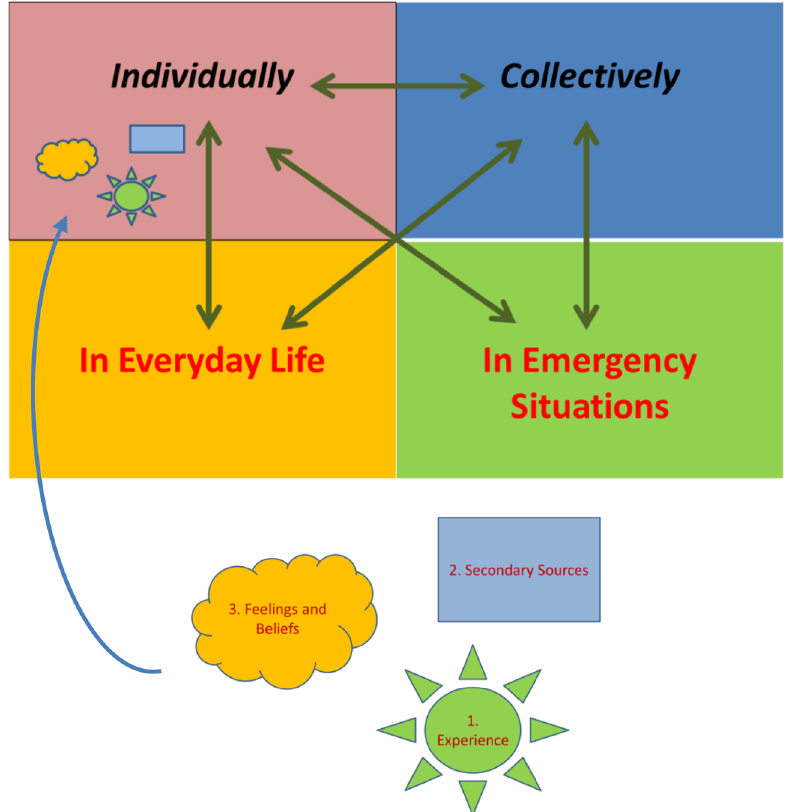
Fig. 4 Learning disaster risk and development individually and